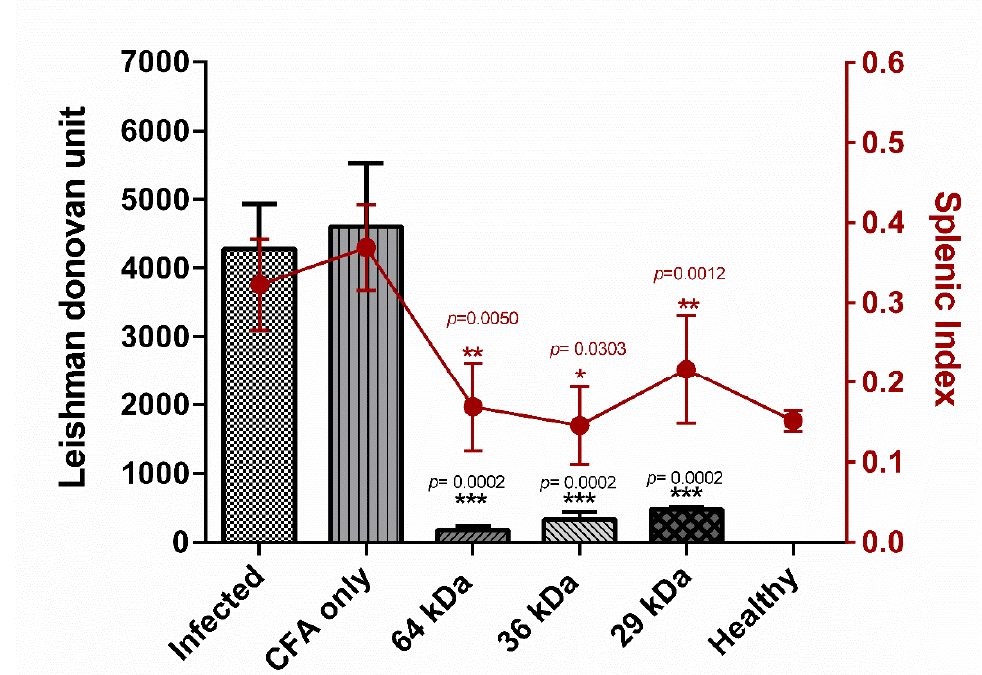
Figure 2. Mean parasite load and splenic index from the spleen of different animal groups. LDU = Leishman Donovan unit. (number of amastigotes/number of nucleated cells × weight of the organ(mg)). Splenic index, the ratio of (spleen weight/whole body weight) × 100. n = 8. Mean ± SEM. Statistical comparison between Infected and test group. Student’s t -test. Level of significance, ns p > 0.05, * p ≤ 0.05, ** p ≤ 0.01, *** p ≤ 0.001.